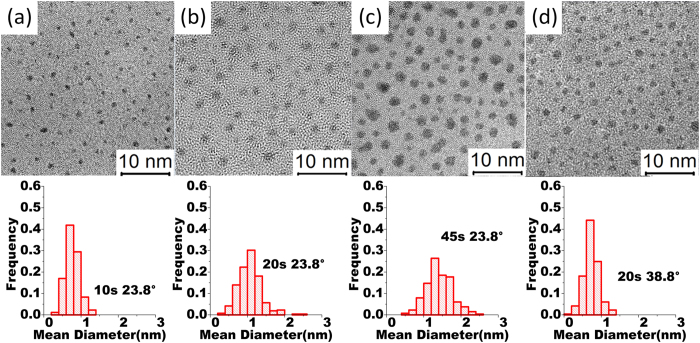
TEM image of TTS-deposited Pt NPs with deposition conditions of (a) 10s 23.8° LD, (b) 20s 23.8°, (c) 45s 23.8°, (d) 20s 38.8° HD and their corresponding size distribution. Adapted from ref. 21.